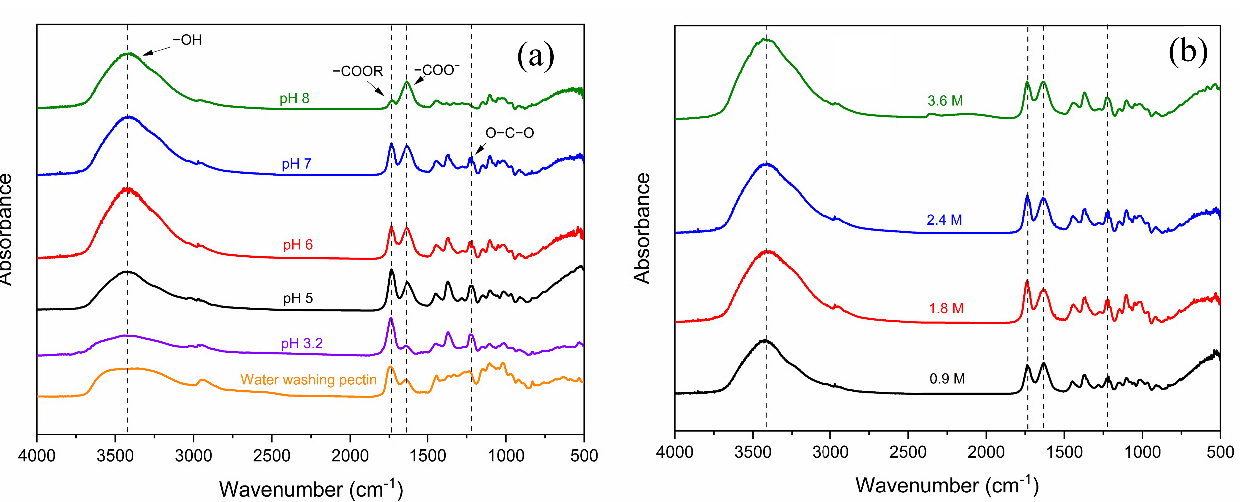
Figure 6. Chemical confirmation of pectin hydrogel at different ( a ) pH values and ( b ) calcium con- centrations.